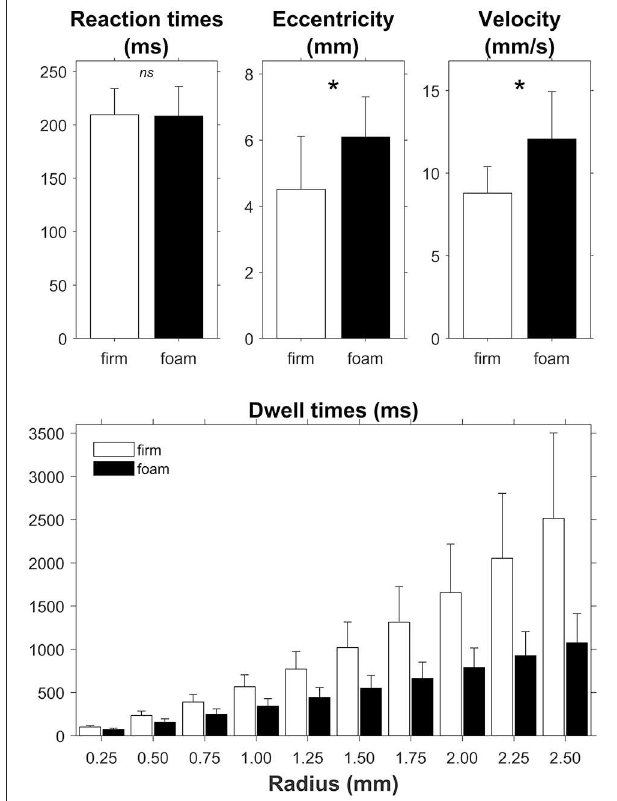
FIGURE 3 | Effect of support surface (firm, white bars and foam, black bars) on reaction times and the global posturographic outcomes eccentricity, velocity and dwell times, the latter presented for a range of radius values. Error bars represent standard deviations. Asterisks in the top panels denote a significant difference between firm and foam conditions. The difference between firm and foam was significant across all radii (bottom panel).